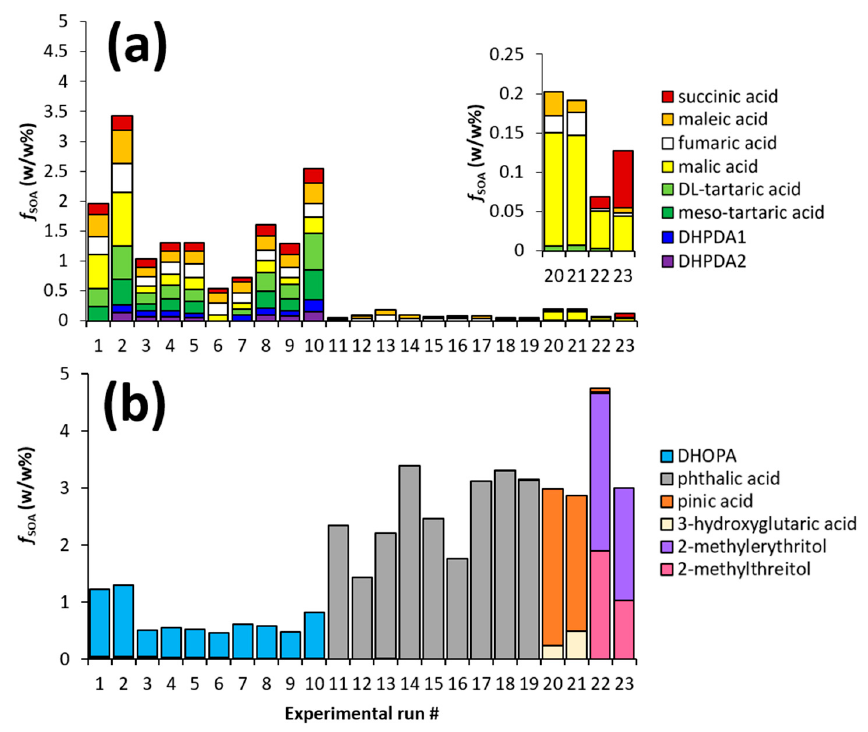
Figure 1. Ratio of tracers to total SOA mass ( f SOA ) determined for ( a ) C4 and C5 dicarboxylic acids present in SOA and ( b ) conventional tracers present in SOA. The insert shows extended figure for results of biogenic SOAs (runs 20–24). DHPDA represents 2,3-dihydroxypentanedioic acid.